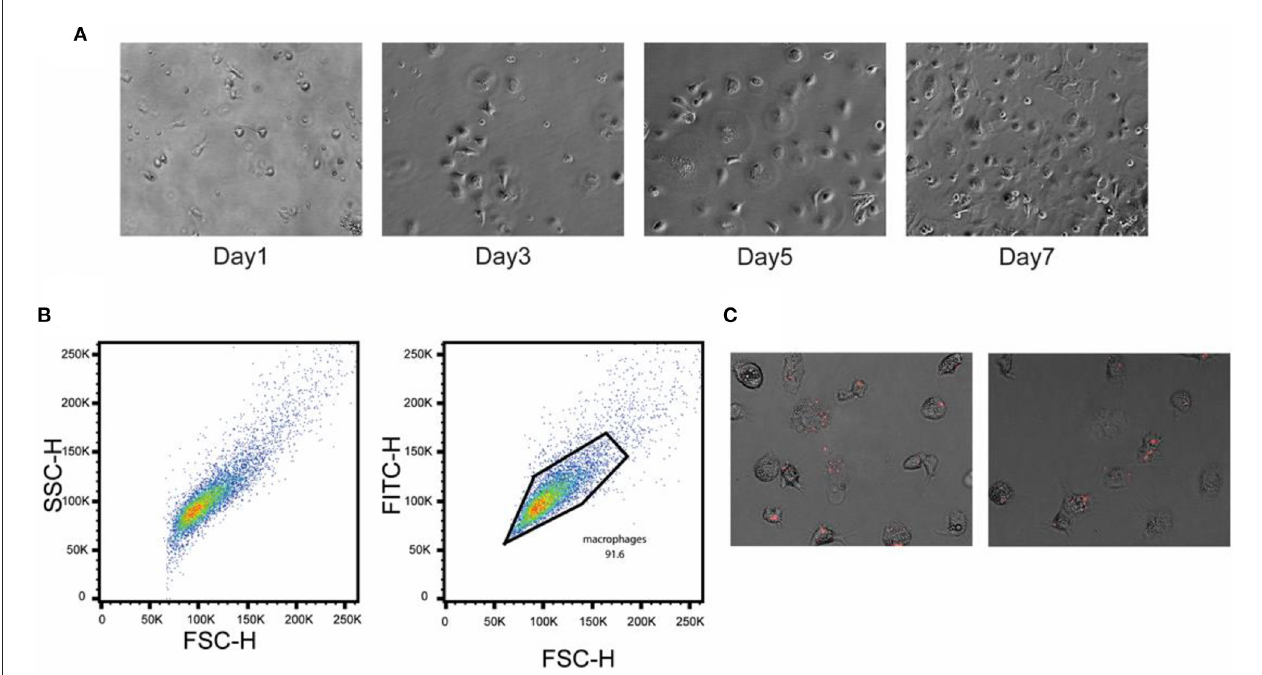
FIGURE 6 | Confirmation of differentiation of chicken PBMCs into primary macrophages. PBMCs were isolated from the heparinized blood collected from healthy birds and separated using Histopaque 1077. (A) Phase-contrast images of cultured chicken PBMCs at different time points. (B) Flow cytometric analysis showing the